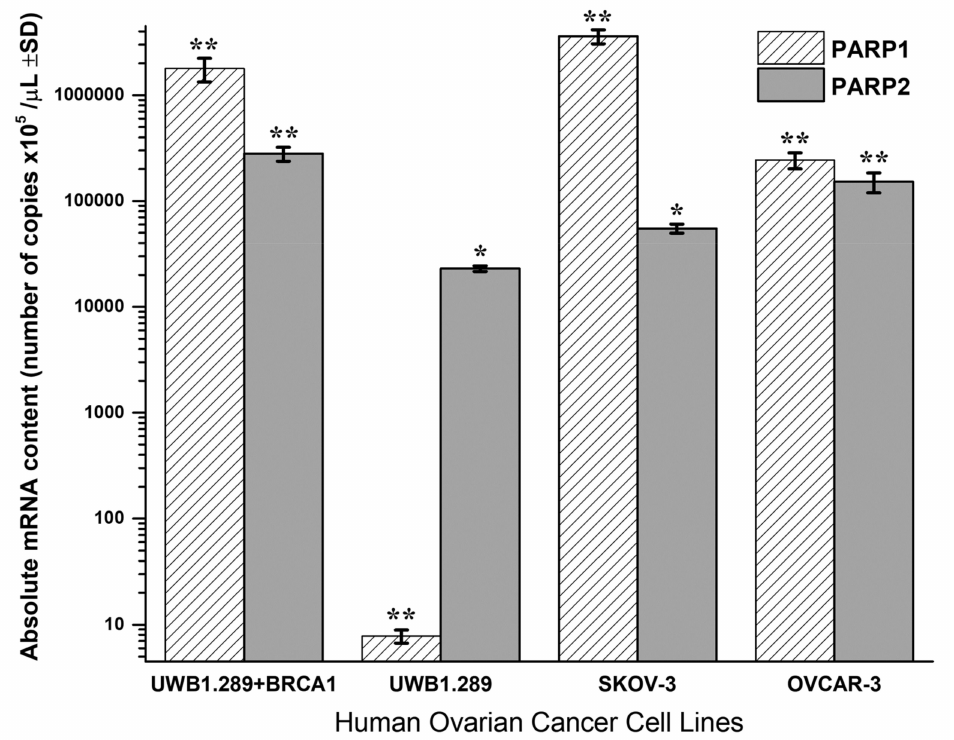
Figure 4. Absolute mRNA cellular content and transcription of PARP1 and PARP2 ( ± SD) in untreated UWB1.289 + BRCA1, UWB1.289, SKOV-3 and OVCAR-3 human ovarian cancer cell cultures at the exponential phase of cell growth. Significance levels in between PARP1 or PARP2 mRNA transcription in the tested ovarian cancer cell lines were denoted, (**) for p < 0.0001 and (*) for p <